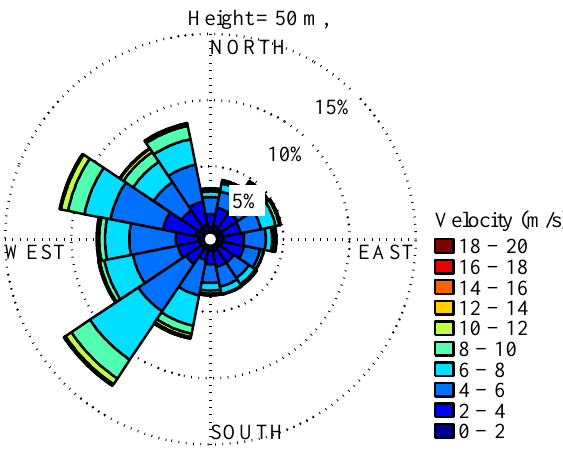
Figure 10: Turbulence